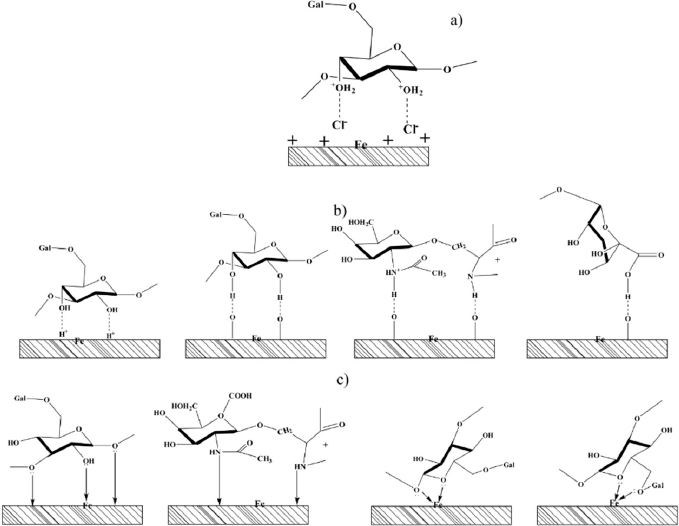
Figure 16. Schematic representation of the corrosion inhibition mechanism of the N80 carbon steel by GA. ( a ) electrostatic; ( b ) H-bond formation; ( c ) chemical adsorption.